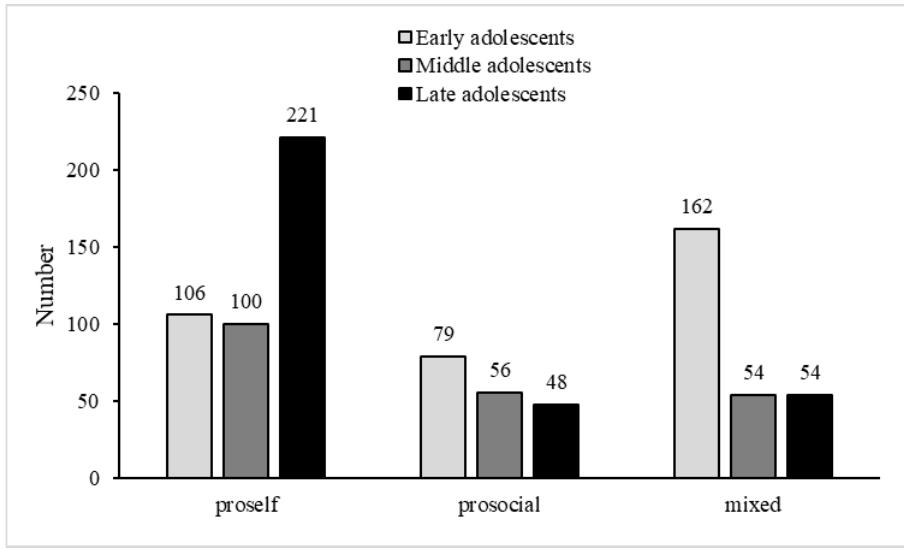
Figure 1. Number of Participants Falling into Three SVOs.